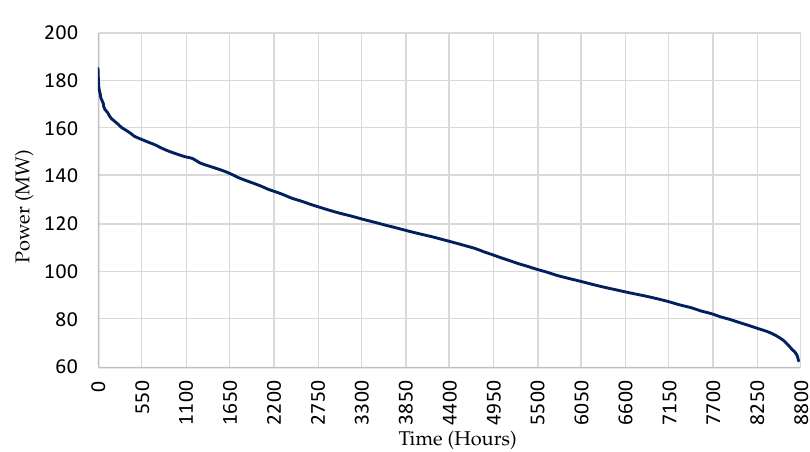
Figure 1. Schematic representation of the single-line RTS [34].